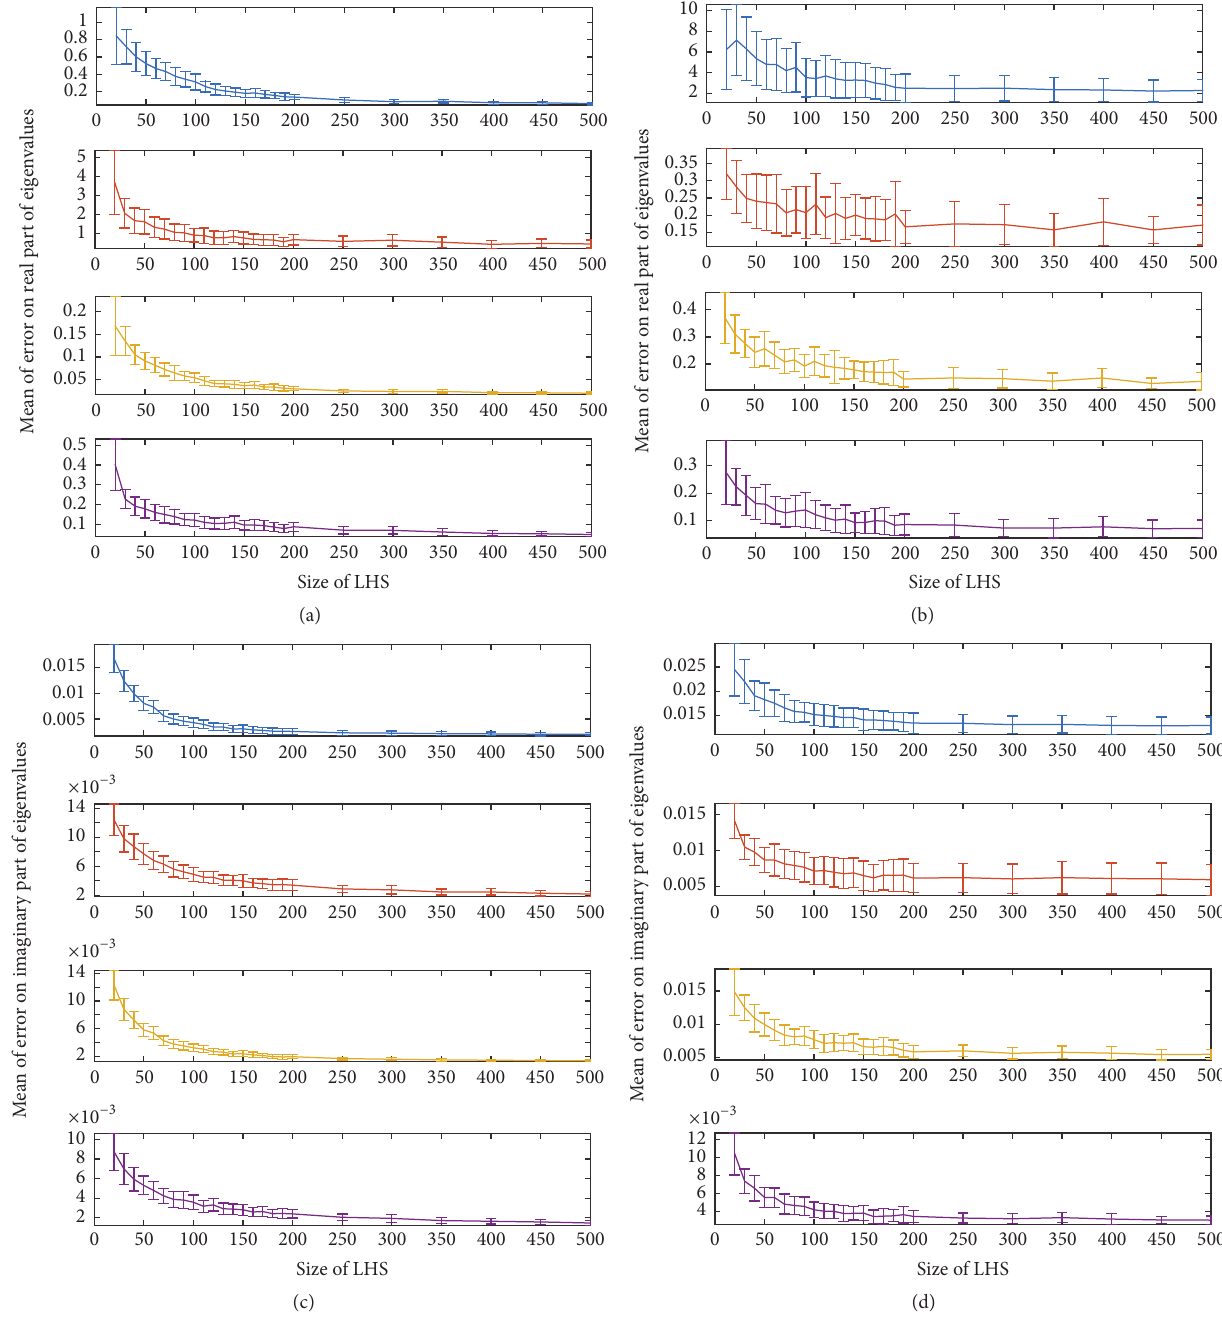
Figure 8: Evolution of the quadratic mean error and the standard deviation error versus the size of the experimental design on real (a, b) and imaginary (c, d) parts of each eigenvalue for configurations 1 (a, c) and 2 (b, d).